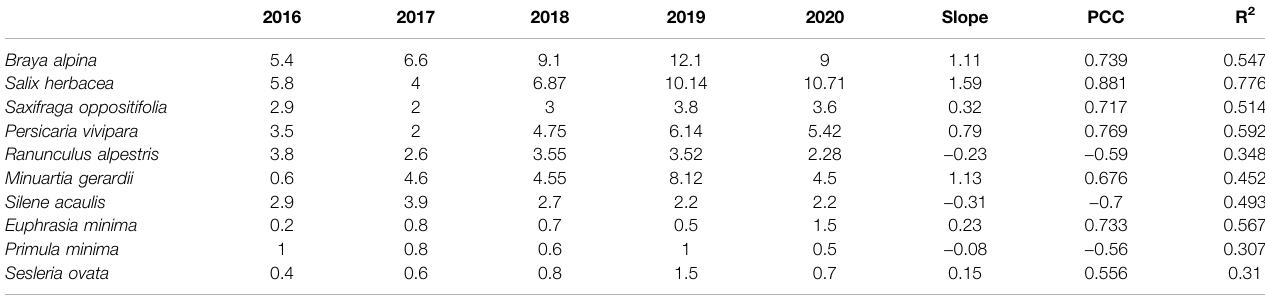
TABLE 4 | Plant species, mean number of individuals (2016 – 2020), slope coef fi cient, Pearson correlation coef fi cient (PCC), and coef fi cient of determination (R 2